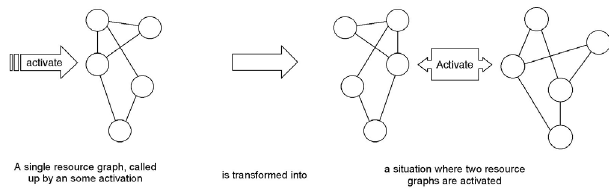
FIG. 10. Dual construction change. In a single situation, one is able to reason clearly using two different